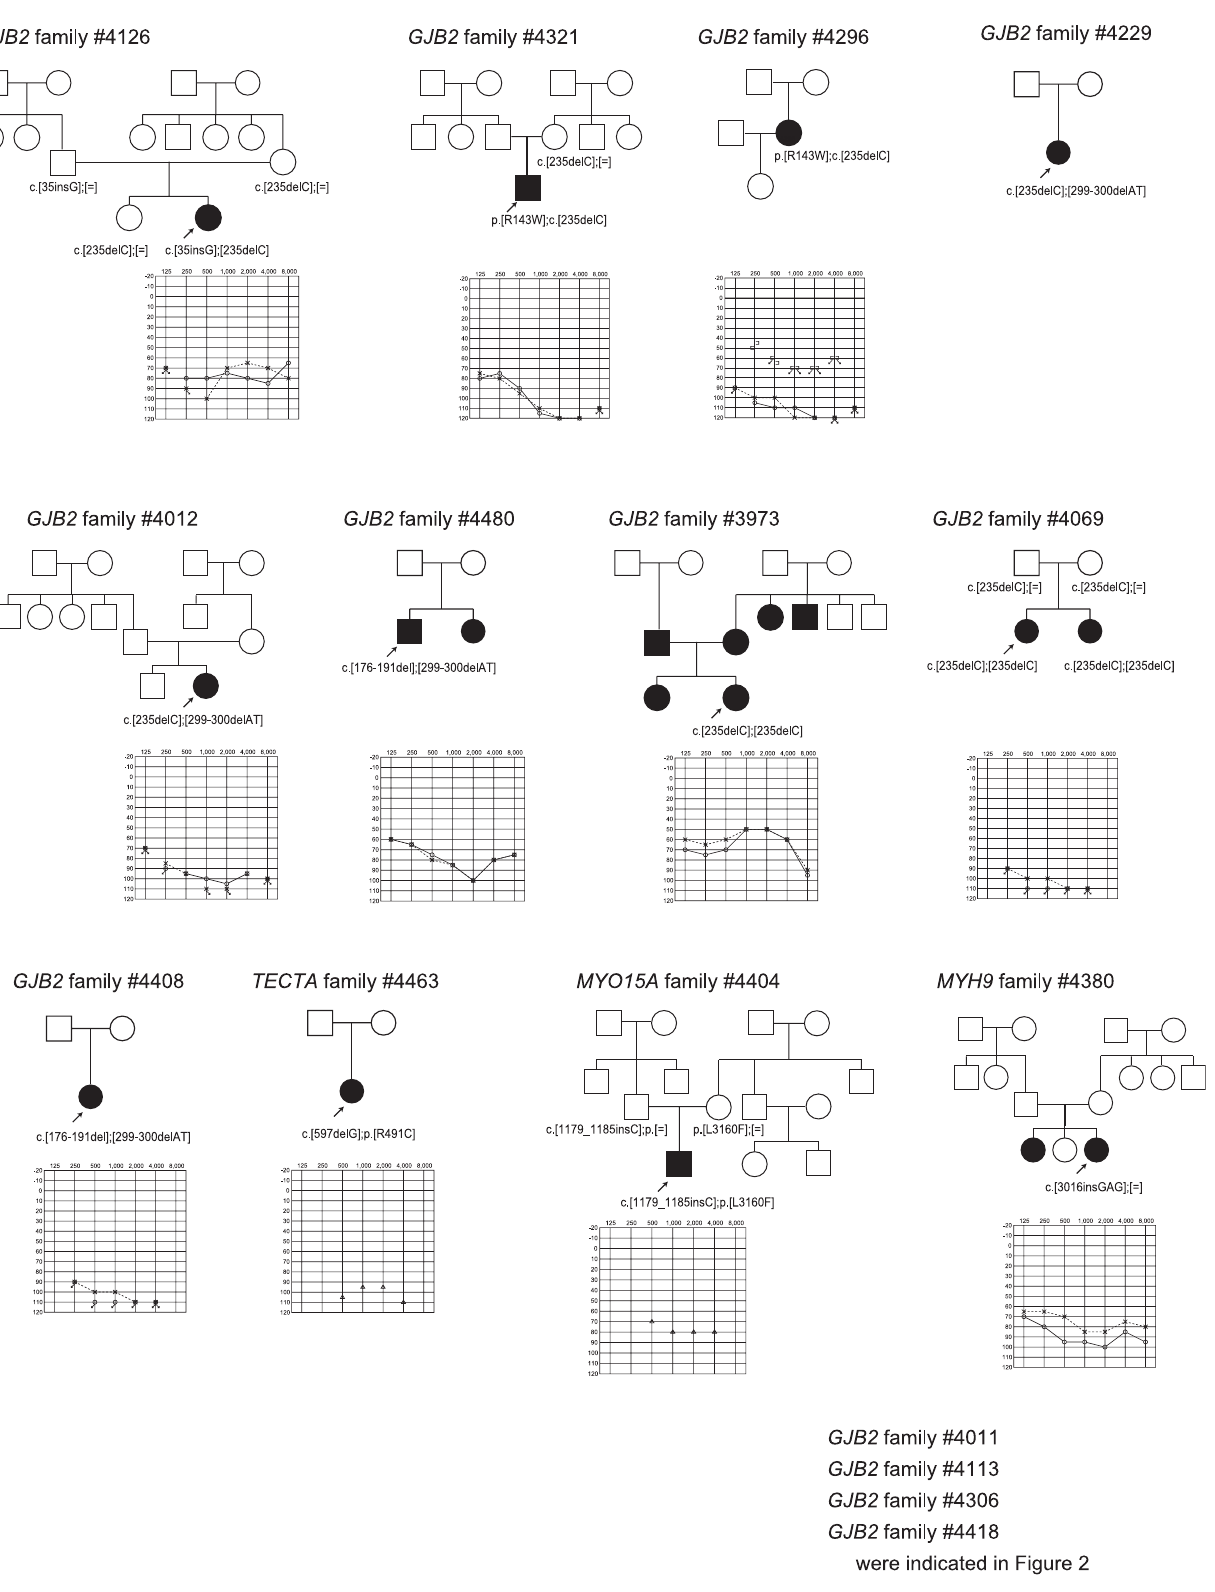
Figure 4. The pedigrees and audiograms of the patients with insertion-deletion mutations after confirmation by Sanger sequencing.